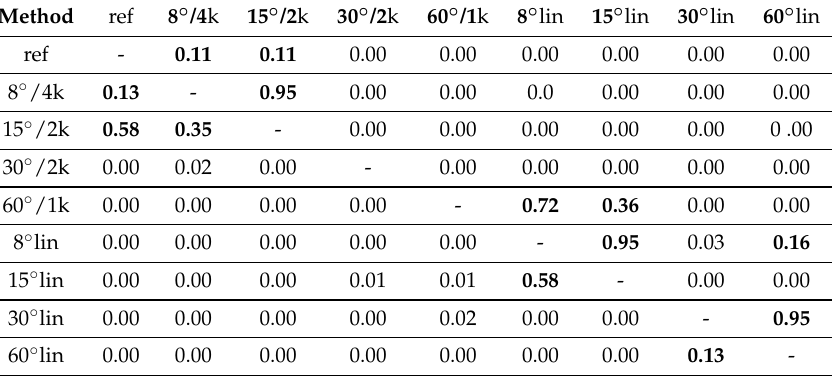
Spatial Mapping: The results for spatial mapping, i.e., localization and distance impression,